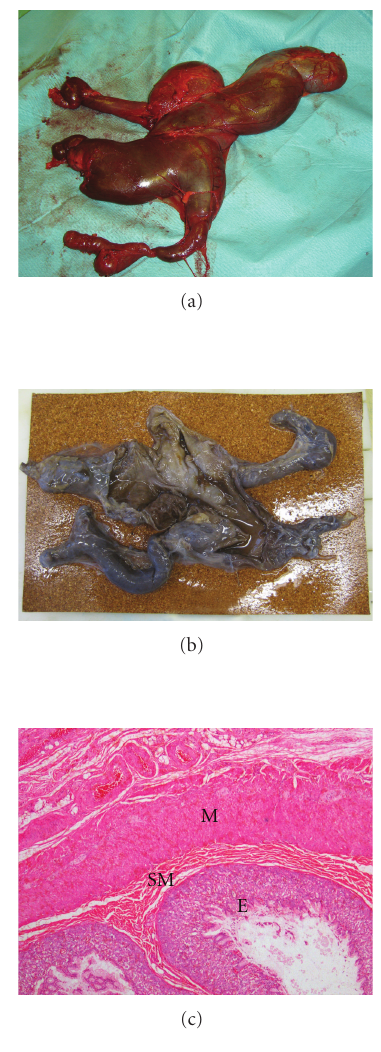
Figure 4: Cystic component of mass. (a) Macroscopic appearance of fresh unfixed specimen. (b) Macroscopic appearance of fixed specimen with cyst opened. (c) Microscopy of haematoxalin and eosin-stained specimen at x2.5 magnification. Layers of enteric lined mucosa comprising of columnar epithelia (E), submucosa (S), and muscularis